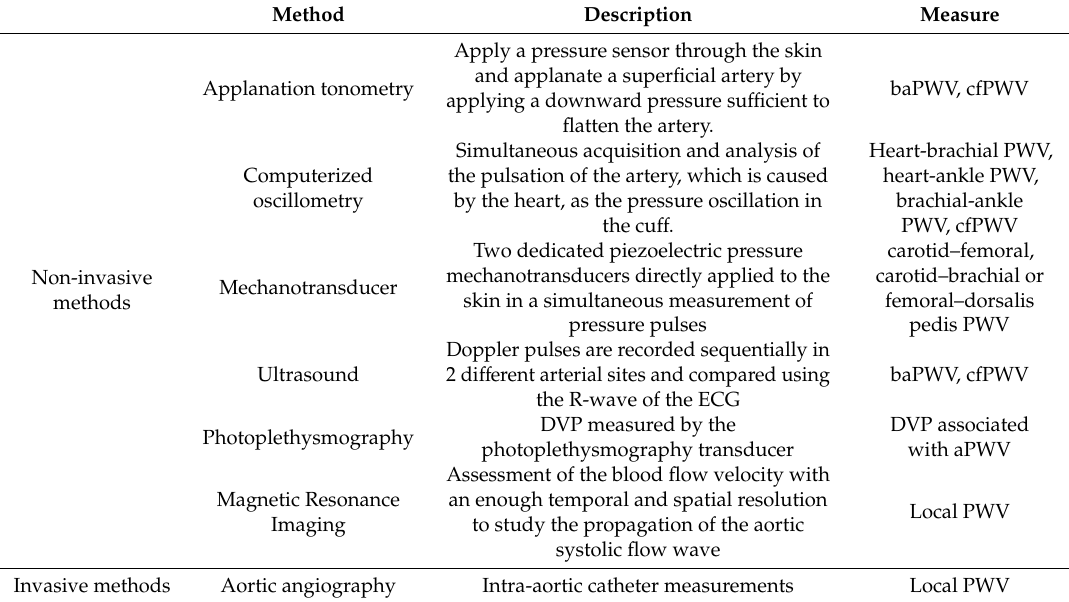
Table 1. Methods used to determine PWV. aPWV: aortic pulse wave velocity; baPWV: brachial-ankle pulse wave velocity; cfPWV: carotid-femoral pulse wave velocity; DVP: digital volume pulse; ECG: electrocardiogram; PWV: pulse wave